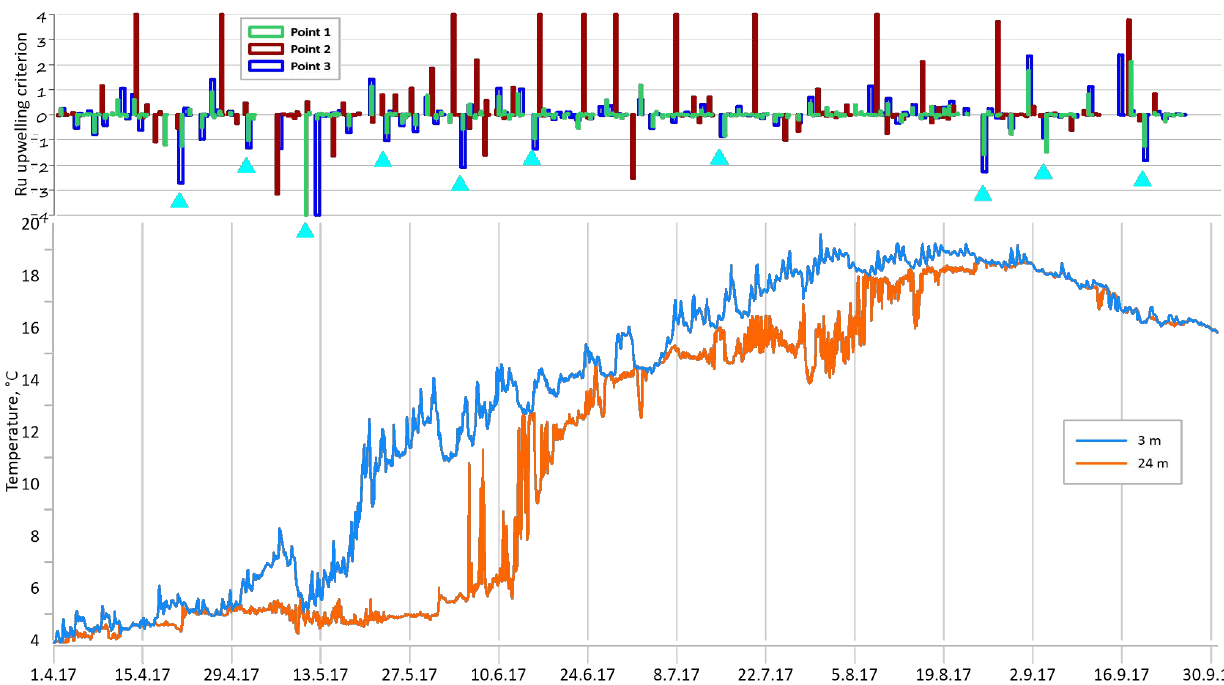
Figure 7. Water temperature and upwelling criterion at points 1, 2, and 3 from 1.04.2017 to 1.10.2017. Blue triangles mark upwelling events. Table 1. Events with an upwelling criterion of less than − 1 and observed temperature